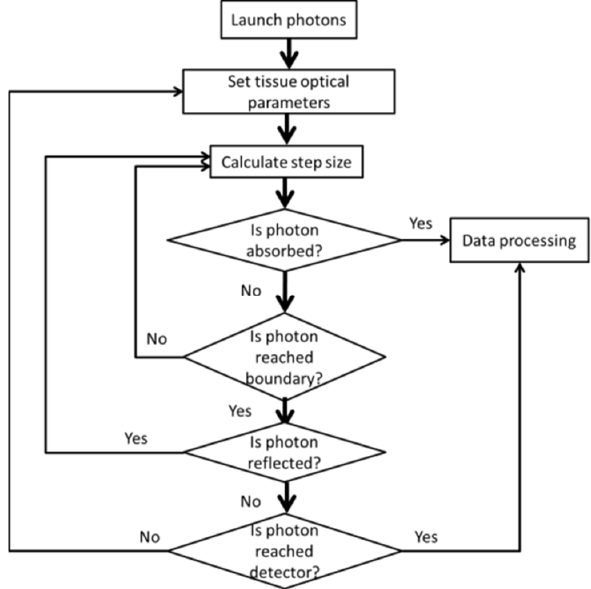
Figure 5. Flow chart of the Monte-Carlo